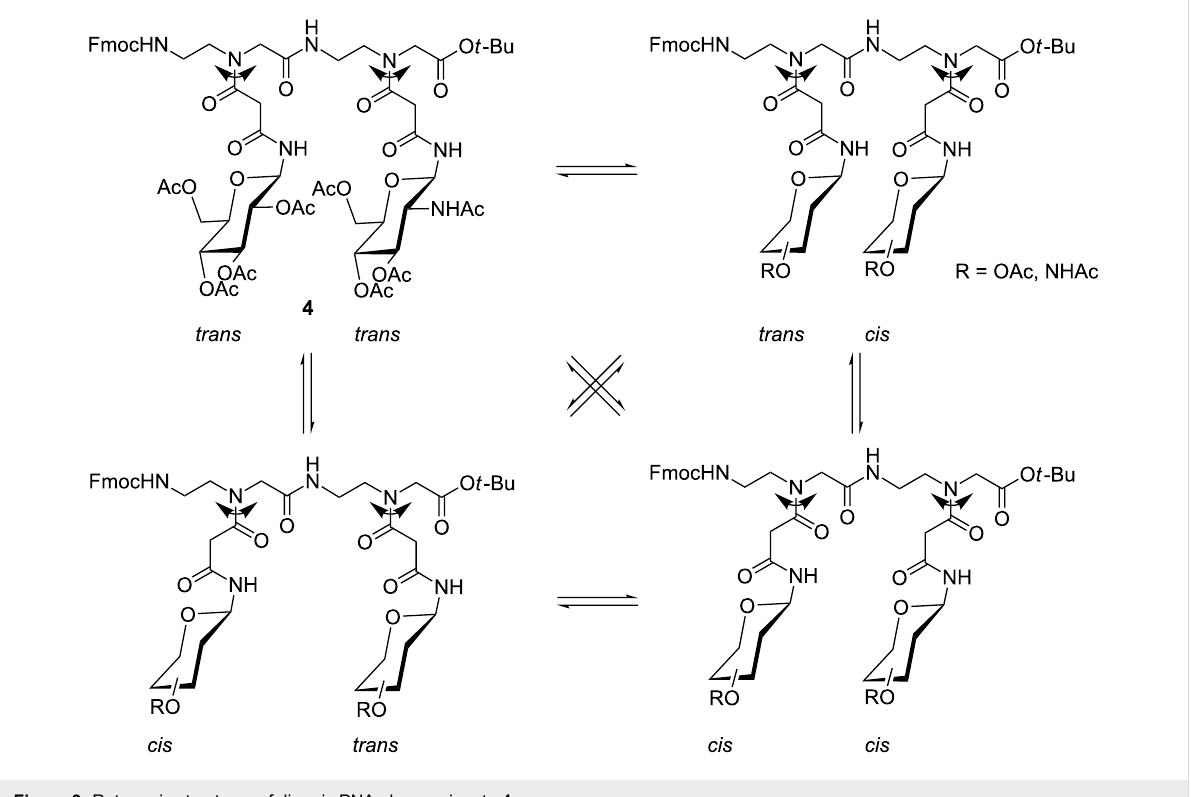
Figure 3: Rotameric structures of dimeric PNA glycoconjugate 4 .